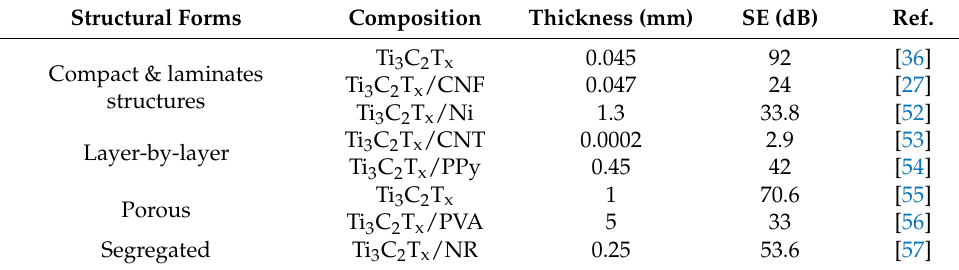
Table 1. EMI shielding performance of various structural forms based on